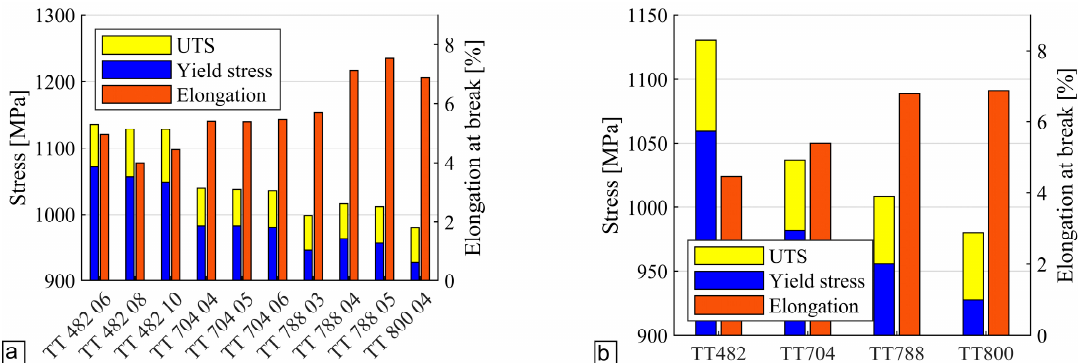
Figure 12. ( a ) Yield stress, ultimate tensile strength and elongation at break for the heat-treated samples; ( b ) same quantities averaged over the postprocessing temperature.